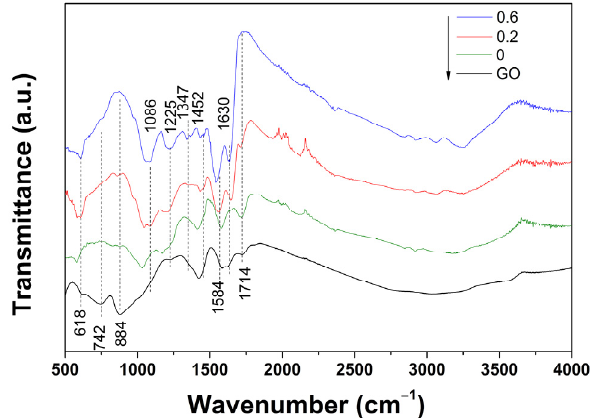
Figure 4. FTIR spectra of GO nanomaterials and modified GO aerogels with PAMAM concentration (mg mL − 1 ).